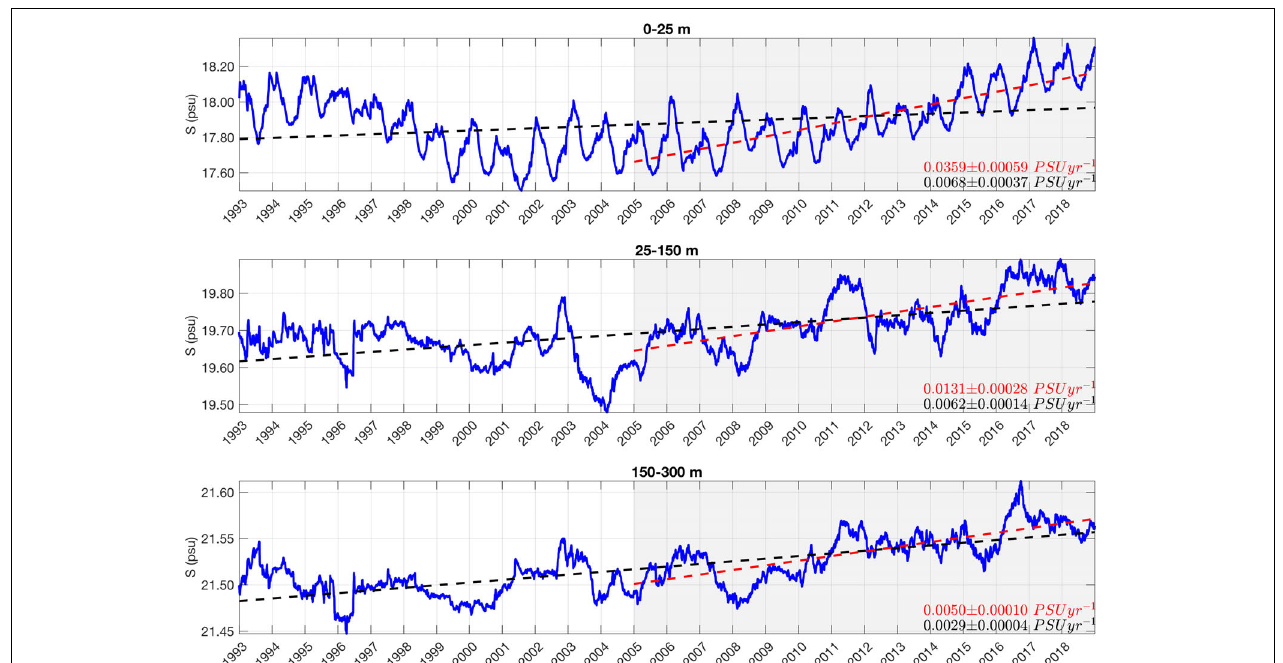
FIGURE 9 | Time evolution of the basin-averaged salinity in PSU computed from BS-REA in different layers: 0–25 m (top), 25–150 m (central), and 150–300 m (bottom). The dashed lines are the linear trends for the period 1993–2018 (black) and 2005–2018 (red), mean trend values are also reported in the figures (bottom right